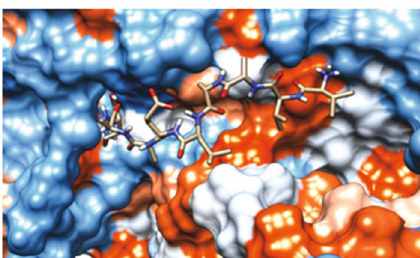
Figure 25: Illustration of the 2D interaction of the best docking poses of VVAALEAAR in the binding sites of HLA-DRB1 ∗